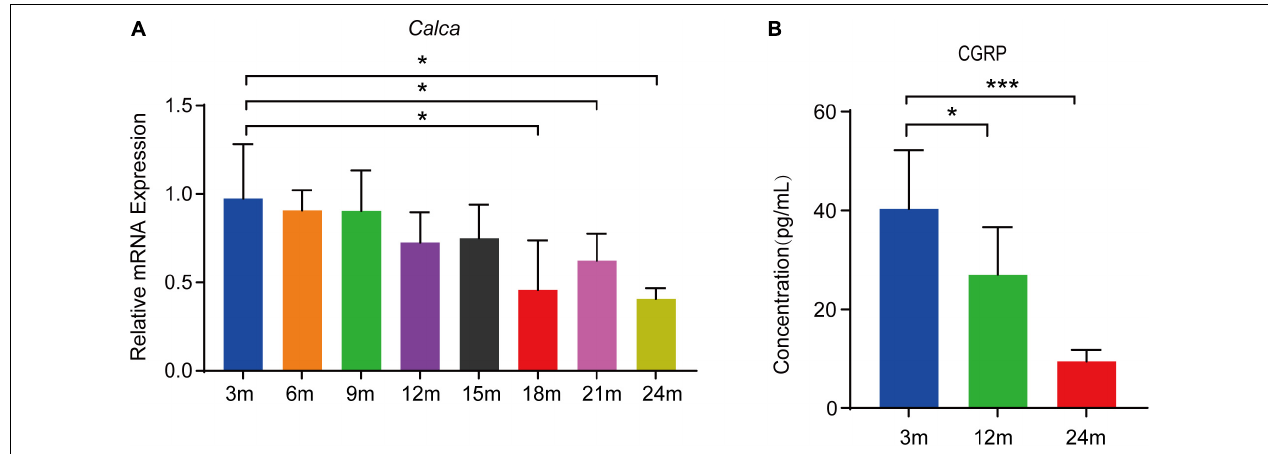
FIGURE 1 | CGRP levels were decreased in the bone marrow supernatant of mice during aging. (A) RT-qPCR analysis of the mRNA level of Calca in bone tissue of mice at 3, 6, 9, 12, 15, 18, 21, and 24 months of age ( n = 5 per age group). (B) The relative levels of CGRP in bone marrow supernatant were measured by ELISA. * P < 0.05, *** P <